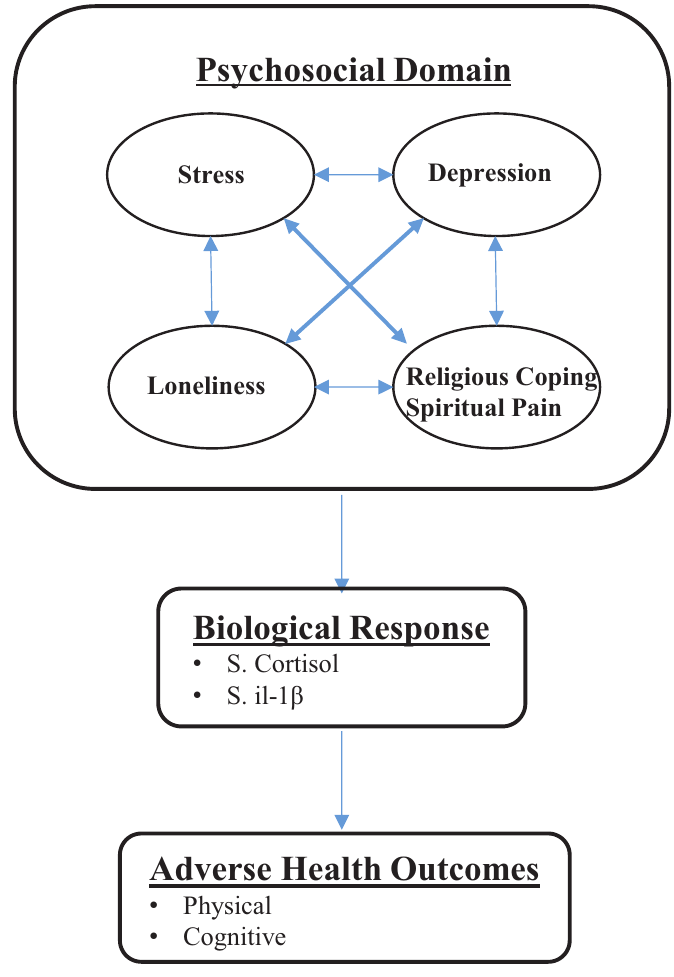
Figure 1. Adapted biobehavioral model for Meals on Wheels ’